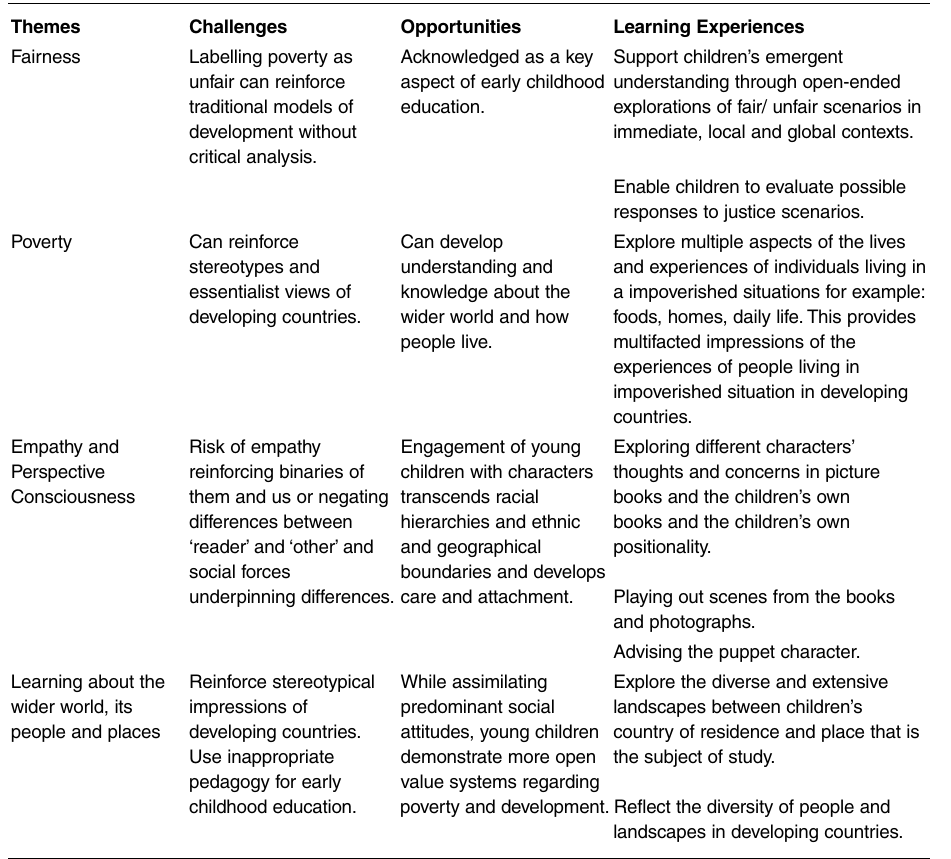
Table 3: Overview of Challenges, Opportunities and Suggestions for a Global Justice Early Childhood Education